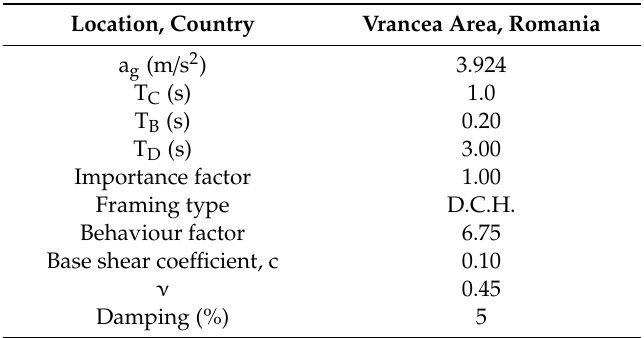
Table 2. Earthquake data computed according to